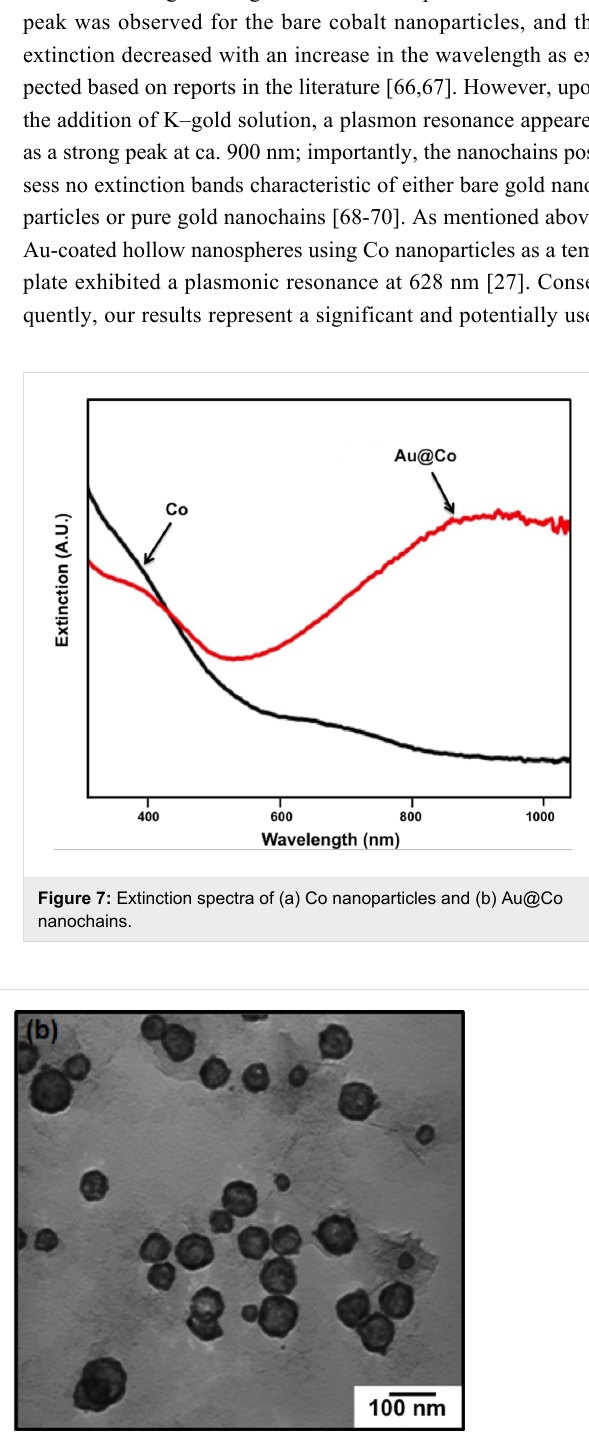
Optical properties of the Au@Co